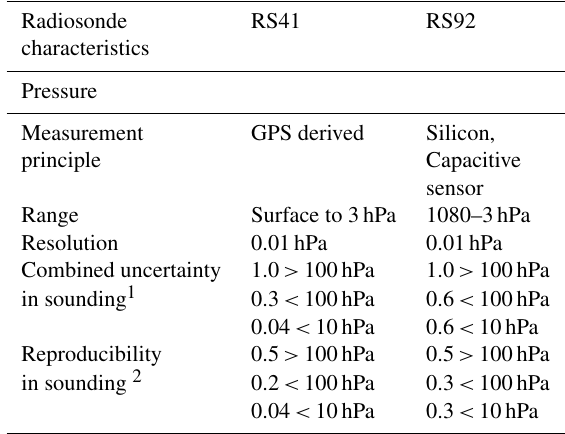
Table 4. Radiosonde pressure sensor measurement specifications (based on Table 5 from Jauhiainen et al., 2014). Radiosonde RS41 RS92